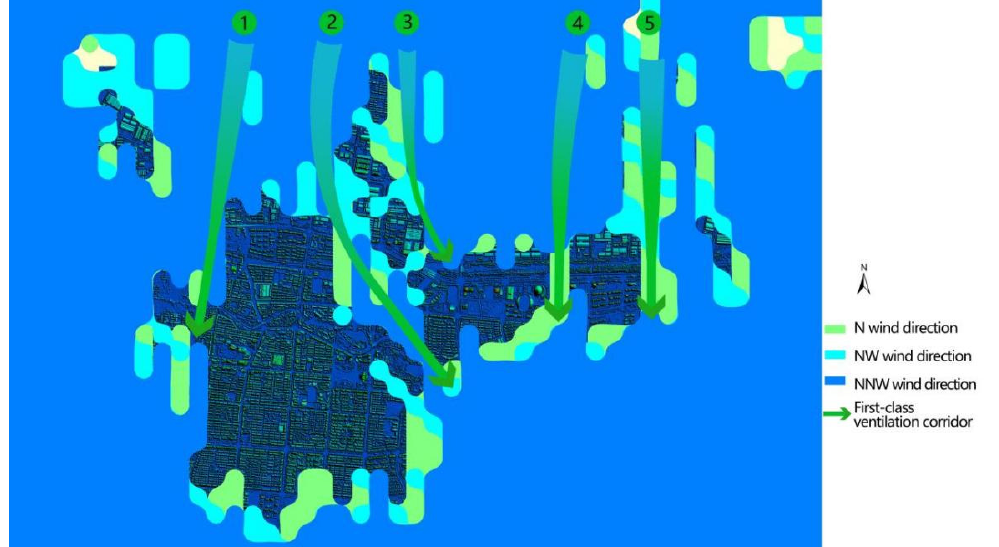
Figure 18. Results of the automatic mining of a 200 m wide and 500 m long corridor (digital surface model (DSM) + corridor).